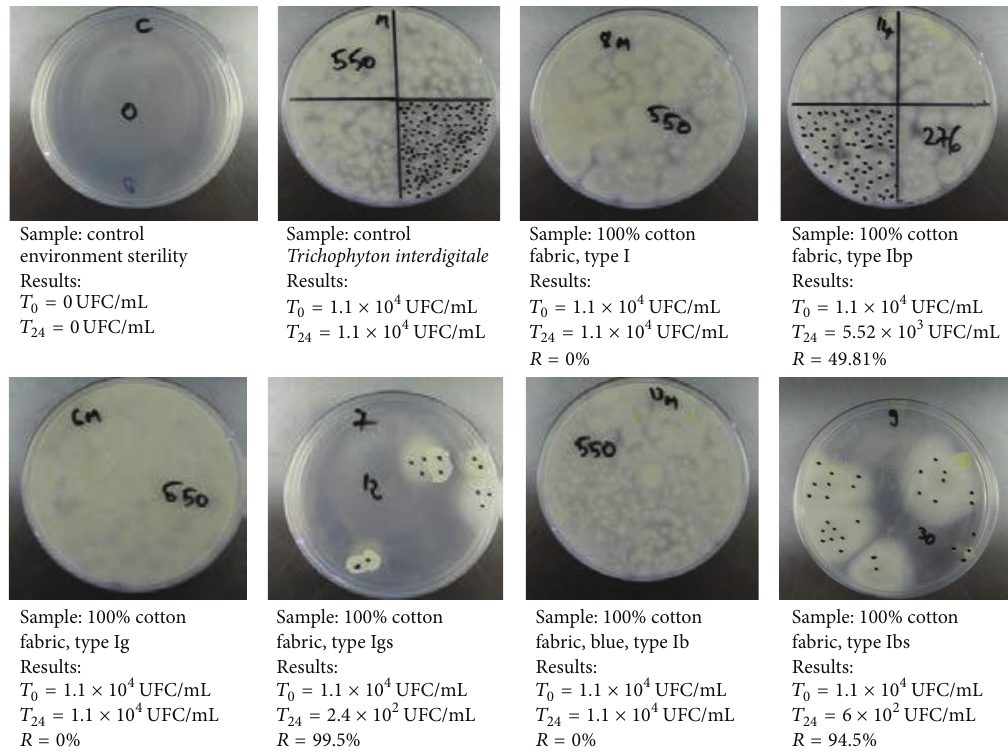
Figure 9: The result of microbiological tests on Trichophyton interdigitale (according to ISO 20743:2007, absorption